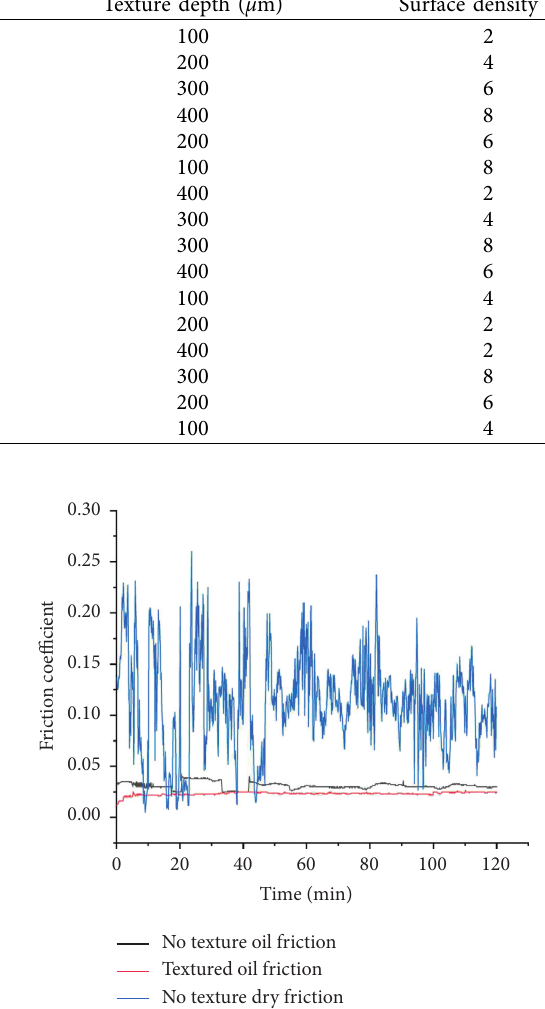
Figure 10: Friction coefficient curves of friction pairs under dif- ferent